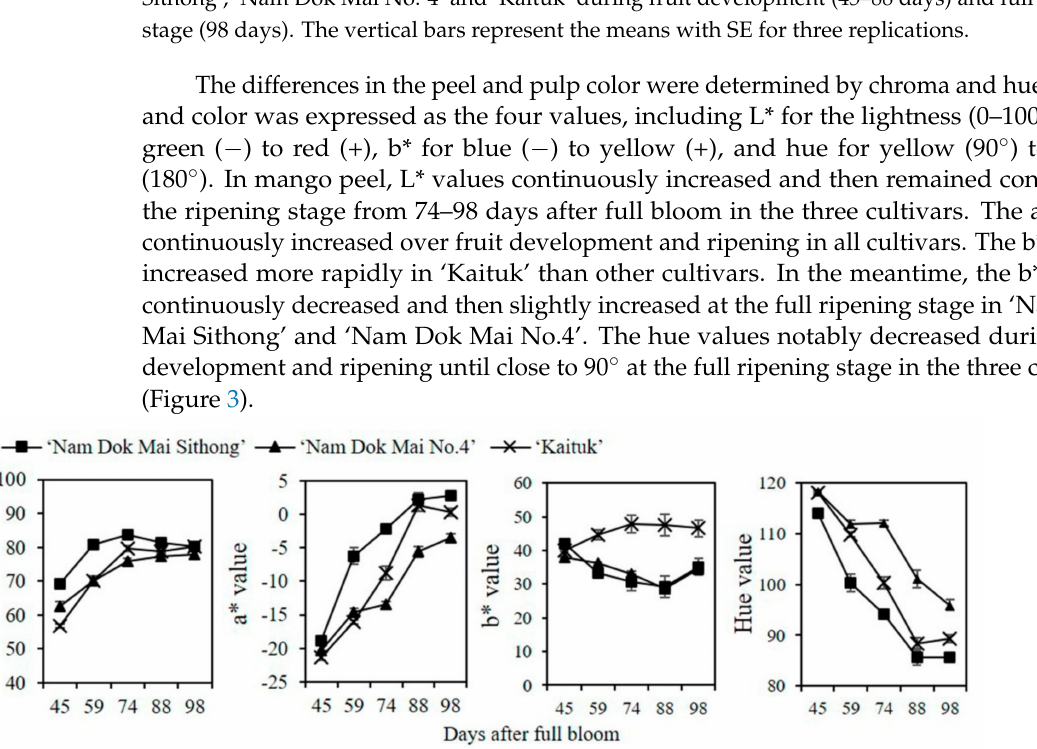
Figure 2. Changes in respiration rate and ethylene production of mango fruit cv. ‘Nam Dok Mai